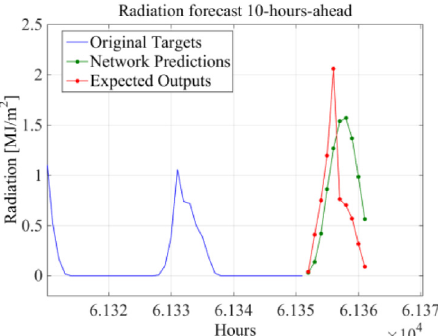
Fig. 7. 10-h-ahead solar irradiation forecast with the NARX network optimized by GA-OBS.